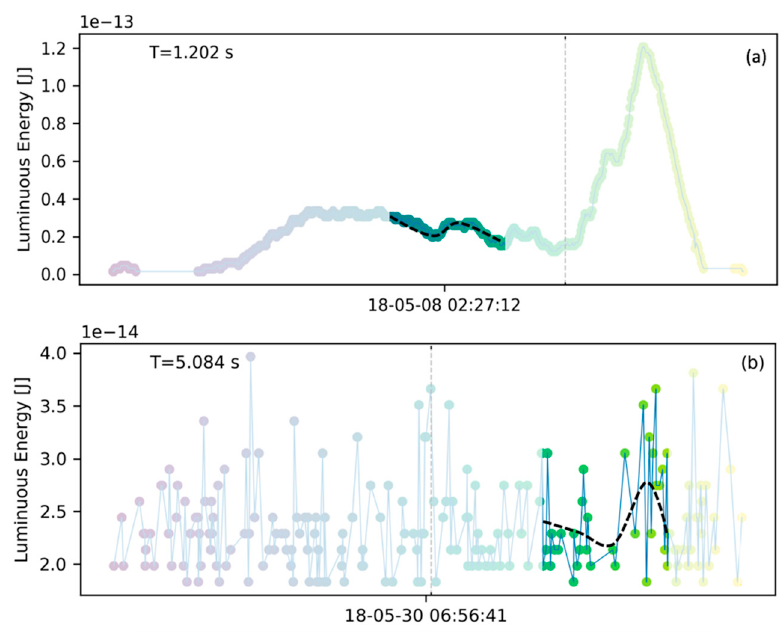
Figure 10. Visualization of the polynomial fit filter. Plot ( a ) shows a bolide light curve. The moving window span is indicated by the clear portion of the plot. A polynomial represented by a dashed line is notionally fitted to the light curve data. Plot ( b ) shows a non-bolide light curve and the fitted polynomial represented by the dashed line. The polynomial fits better the data of the bolide (a) than for the non-bolide (b).